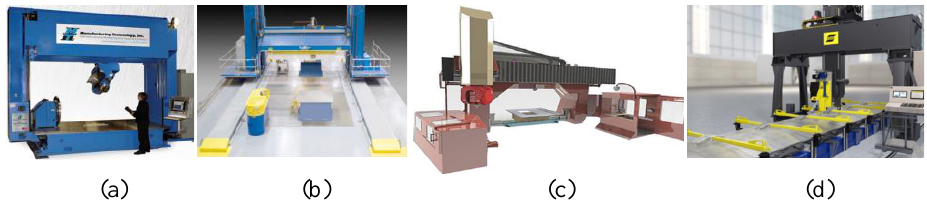
Fig. 3. Portal type machines from MTI (USA) (a), Novatech (USA) (b), Huge (Switzerland) (c), ESAB (Sweden) (d).